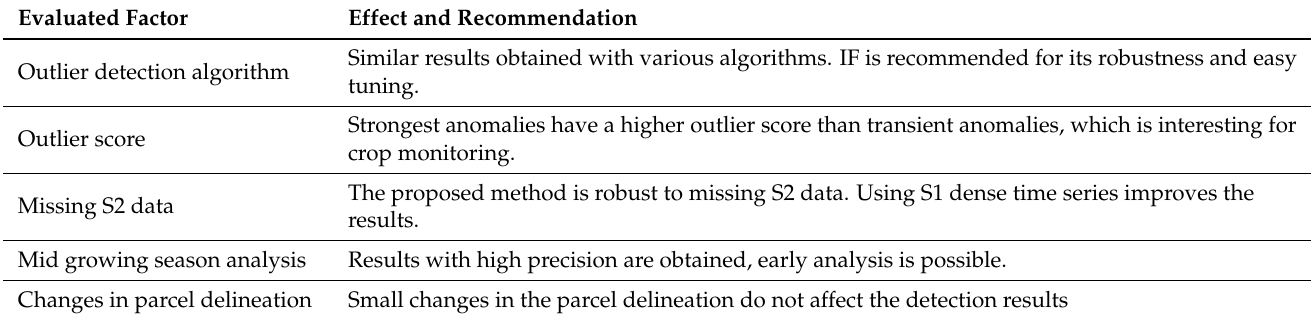
Table 7. Summary of the influence of the different analyzed factors for the detection of anomalous crop development. Evaluated Factor Effect and Recommendation Outlier detection